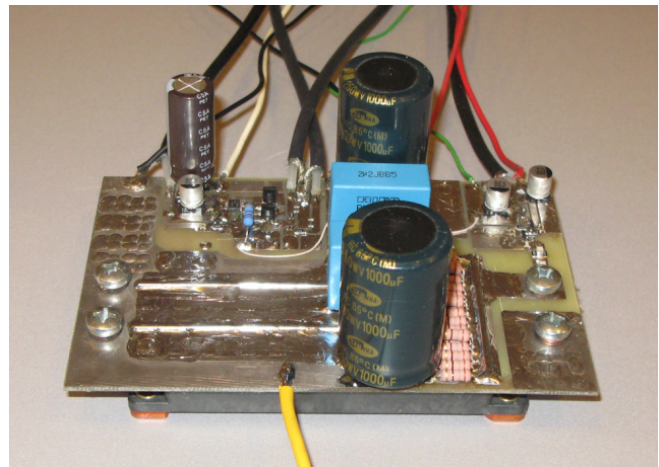
Figure 11. Test-bench PCB with attachment for Mitsubishi Electric CM450DX-24S module. Figures 12 and 13 represent the results for 15 V of input. Once again, the new model demonstrated high accuracy in comparison with measurements.